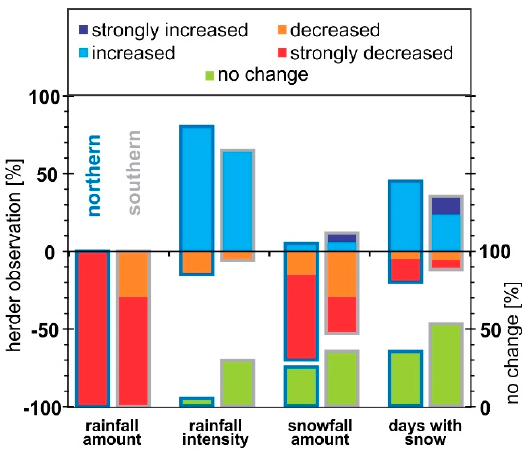
Figure 3. Summary of the herder observations with Northern and Southern soums responses in the blue and grey boxes, respectively. Note that no change is illustrated on the right y -axis. Table 1. The setup of the four survey questions administered to the herders used in this paper, relating to (i) rainfall amount, (ii) rainfall intensity, (iii) snowfall amount, and (iv) snowfall frequency. The responses (a) through (e) were recoded to a scale of − 2 to +2.